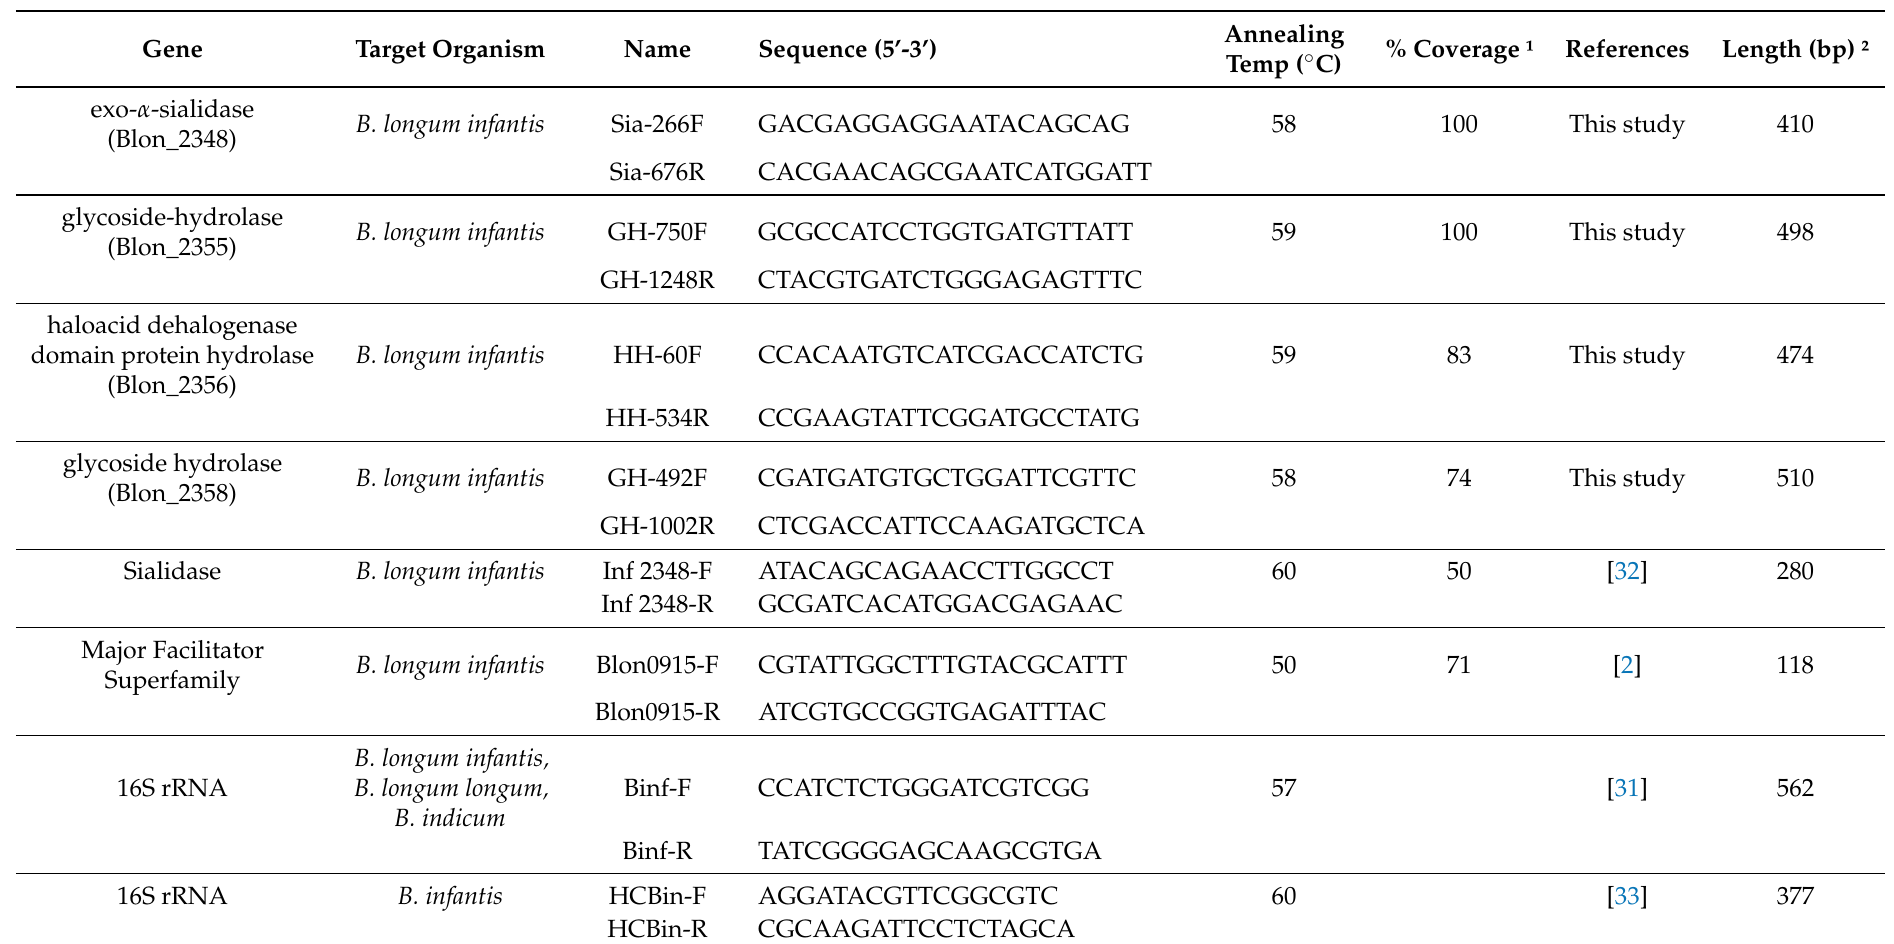
Table 1. Primers targeting HMO metabolizing and 16S rRNA